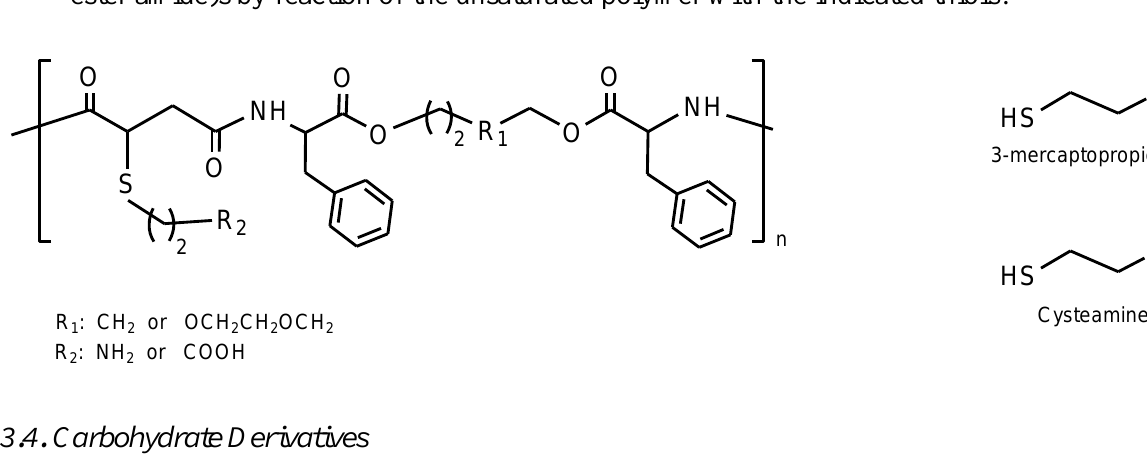
Figure 18. Amino and carboxylic acid functionalized poli(ester amide)s and poly(ether ester amide)s by reaction of the unsaturated polymer with the indicated